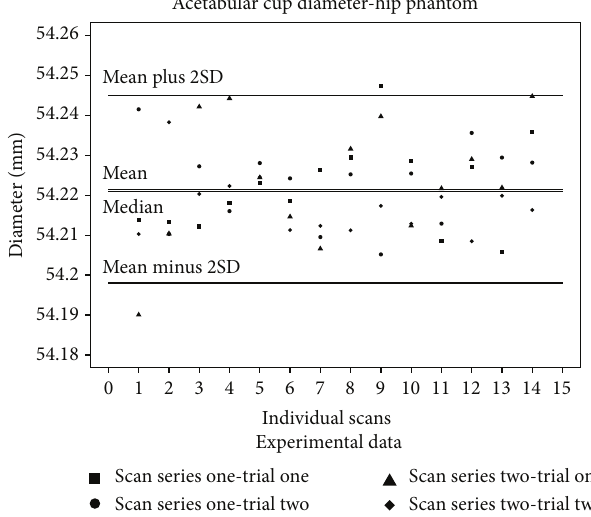
Figure 5: The values of the acetabular cup diameters obtained from each individual calculation are shown with the median, mean, and twoSDlinesdrawnthroughthedata. Themedianvalueisquiteclose to the mean value.